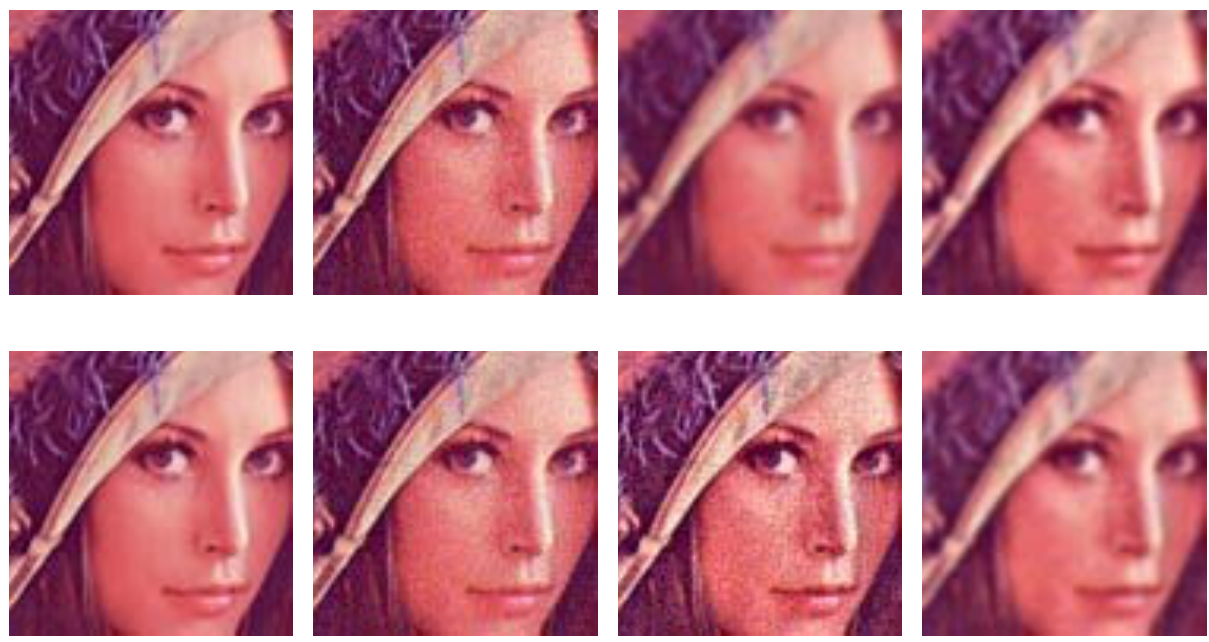
Fig. 7 First row, original Parrot image, filtered with UM and with CLAHE. Second row, a little detail region.